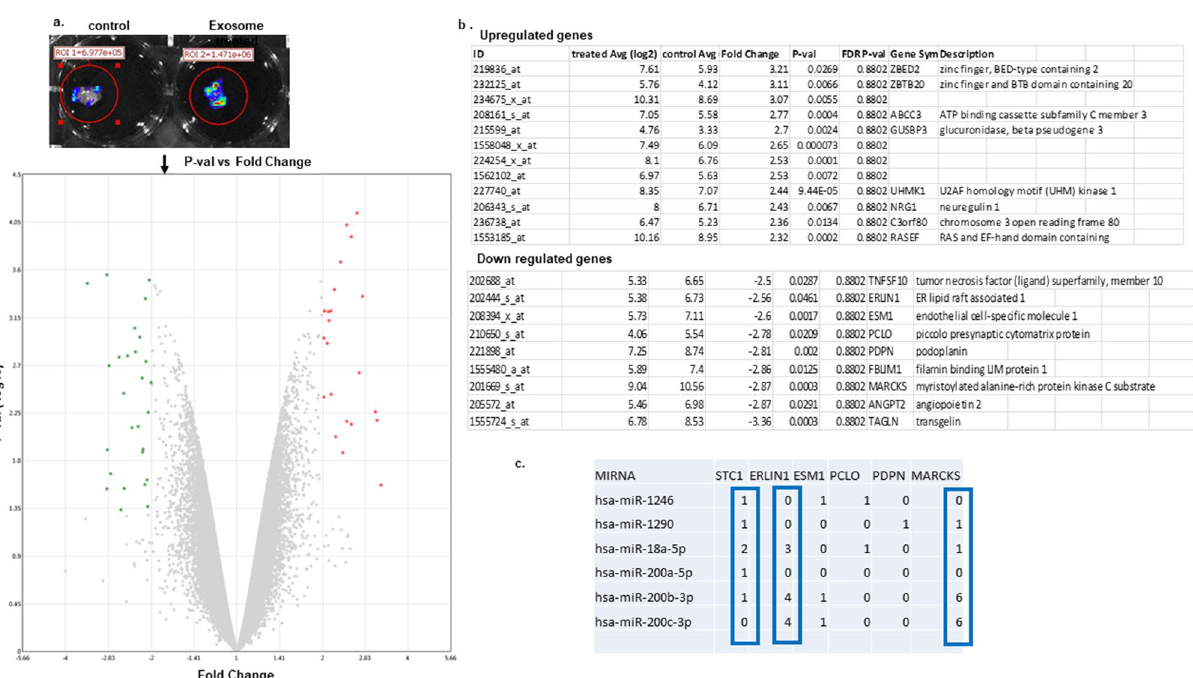
Figure 6. Ex vivo migration assay. Luciferase labeled SKOV3cells were allowed to migrate towards pieces of fresh omentum, which are either untreated (control) or treated with 500 μg exosomes for 5 days. IVIS imaging shows the increased amount of cells migrated to treated omentum ( a ). The GFP labeled cells were isolated from omentum were allowed to grow, and gene expression assays performed. The upregulated and downregulated genes with two-fold change are shown ( b ). A list of miRNAs predicted to bind to the downregulated genes in the cells migrated towards omentum pretreated with malignant ascitic derived EVs ( c